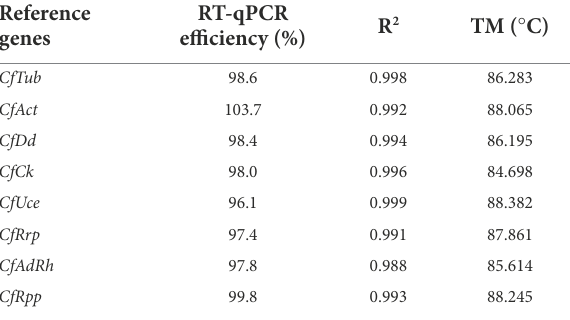
TABLE 2 The primer amplification efficiency and correlation coefficients of candidate reference